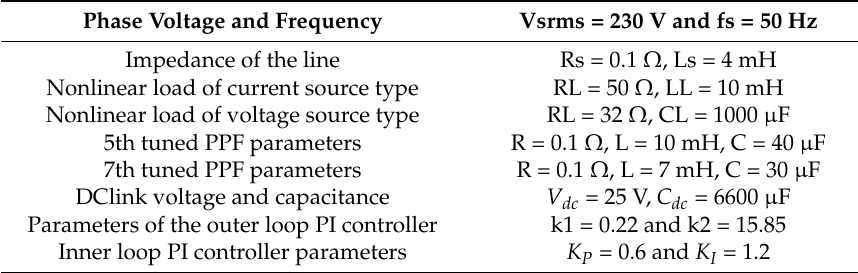
Table 1. Parameters of the